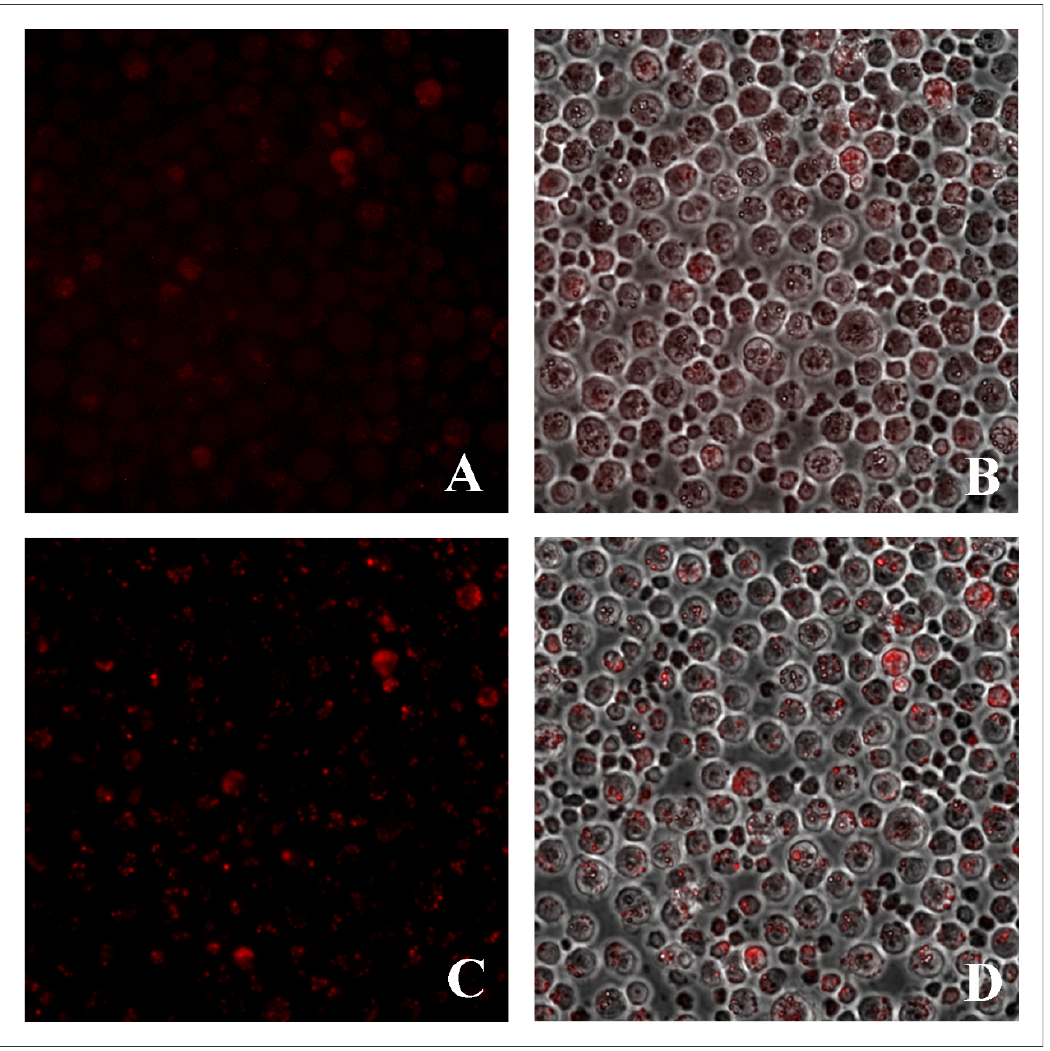
Figure 5. Ehrlich ascites carcinoma cell culture after 1.5 h ( A , B ) and 24 h ( C , D ) of incubation with BODIPY 1 at a concentration of 1 µ M. ( A , C )—fluorescent staining, ( B , D )—overlapping a fluorescent staining with the phase contrast image. Magnification 40 ×